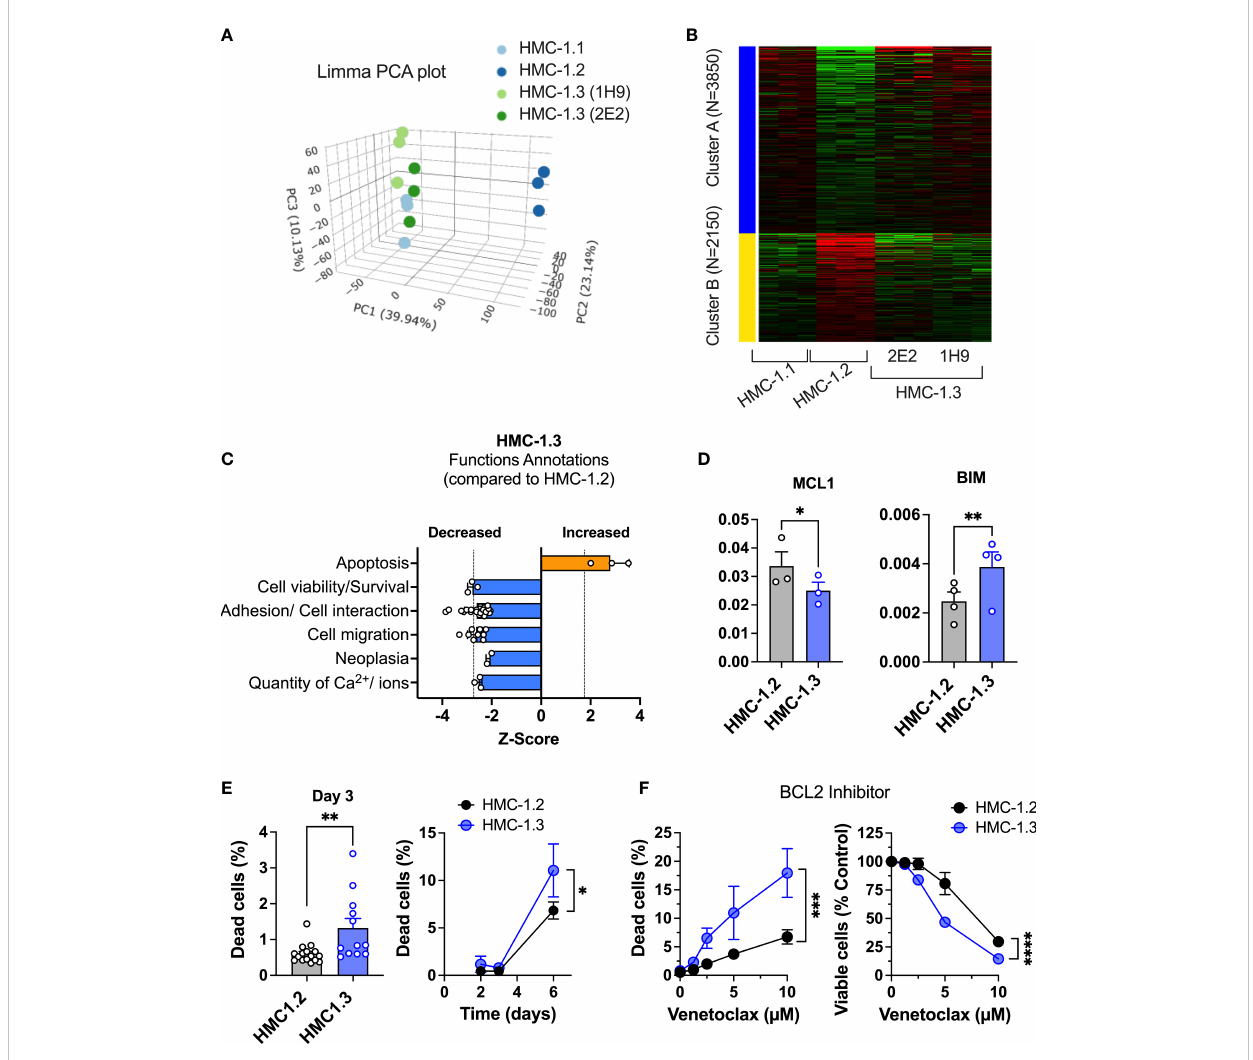
FIGURE 3 Repair of the G560V-KIT mutation in HMC-1.2 results in distinct transcriptional patterns and reduced pathways that promote survival. (A) Principal component analysis plot (Limma) of RNAseq analysis from HMC-1.1, HMC-1.2 and HMC-1.3 subclones illustrating total transcriptional differences between the sublines. (B) Heatmap of 6000 differentially expressed genes between the indicated HMC-1 sublines. (C) Z-Scores of Functions Annotations predicted to be signi fi cantly altered in HMC-1.3 compared to HMC-1.2 using QIAGEN IPA. Each bar represents the average z-scores (Mean ± SD) of similar Functions Annotations terms. These Functional Annotations were categorized by IPA in four top Molecular and Cellular Functions categories: Cellular Movement, Cell Death and Survival, Cell-to-Cell Signaling and Interaction, and Cell Signaling and Molecular